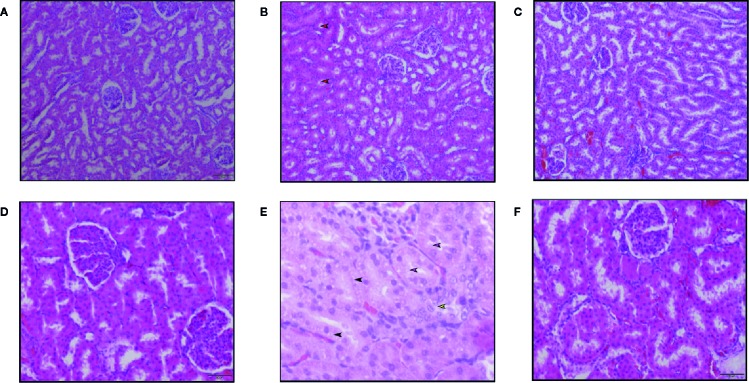
Hematoxylin and eosin staining of kidney sections of Sprague Dawley rats treated with 15 mg/kg/day BW of Vehicle, SM21 and Amphotericin B groups after treatment for 5 days. Six micrographs taken from the cortex of kidney in Vehicle (A, D), Amphotericin B (B, E), SM21 (C, F) groups. Control groups [Vehicle and voriconazole (not shown)] showed no abnormality. SM21 treatment group (SM21 and its analogue) had similar findings of the control groups along with mild tubular necrosis. Among tubular necrosis in Amphotericin B group, loss of the brush border of tubuli (pink arrow in Figure E), mild tubular cell vacuolation (black arrow in Figure E), intratubular cast formation (red arrow in Figure B), disengagement of cells into lumen of tubuli (yellow arrow in Figure E) were significantly observed. SD, Sprague Dawley.